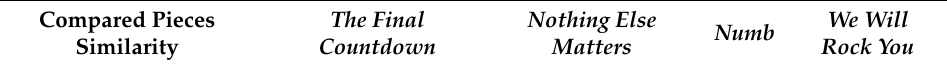
Table 5. Comparison of tracks from the rock music genre.